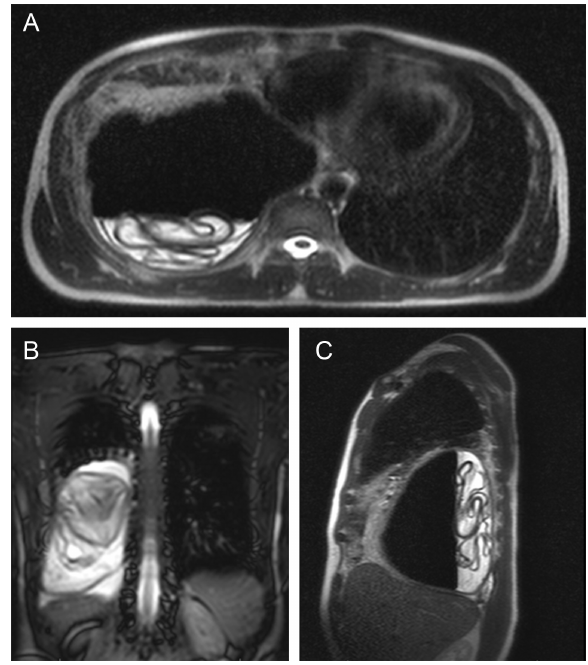
Figure 7. A-C. Axial (A), coronal (B), and sagittal (C) T2-weighted magnetic resonance image shows rupture of giant hydatid cyst in the right lung.